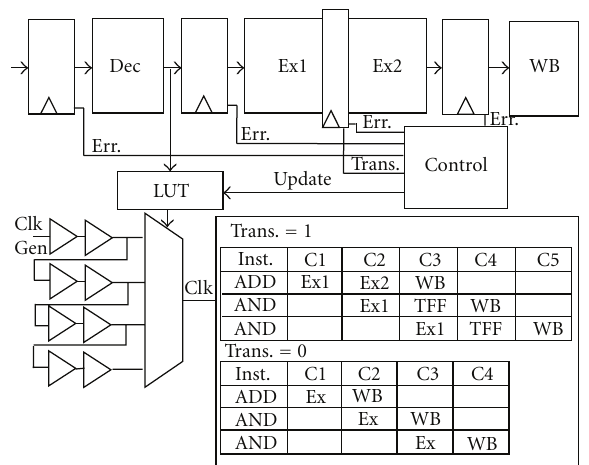
Figure 1: Proposed architecture with a sample instruction flow. When Trans. = 1, pipeline is working in LP mode, otherwise the high-speed mode is applied.